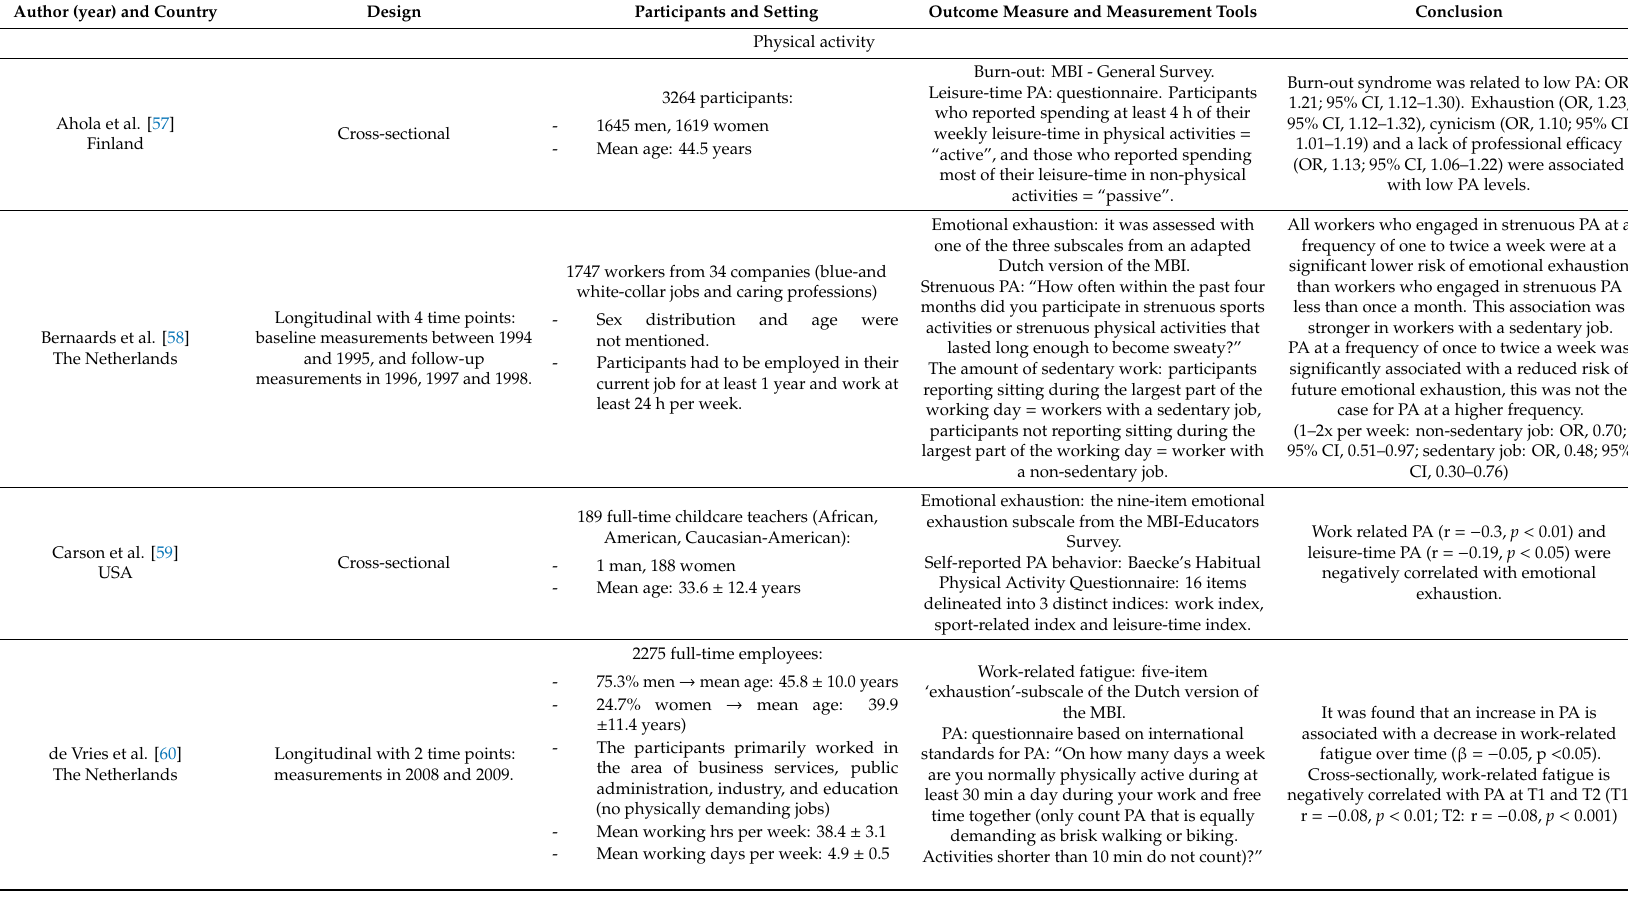
Table 2. Overview of the included observational